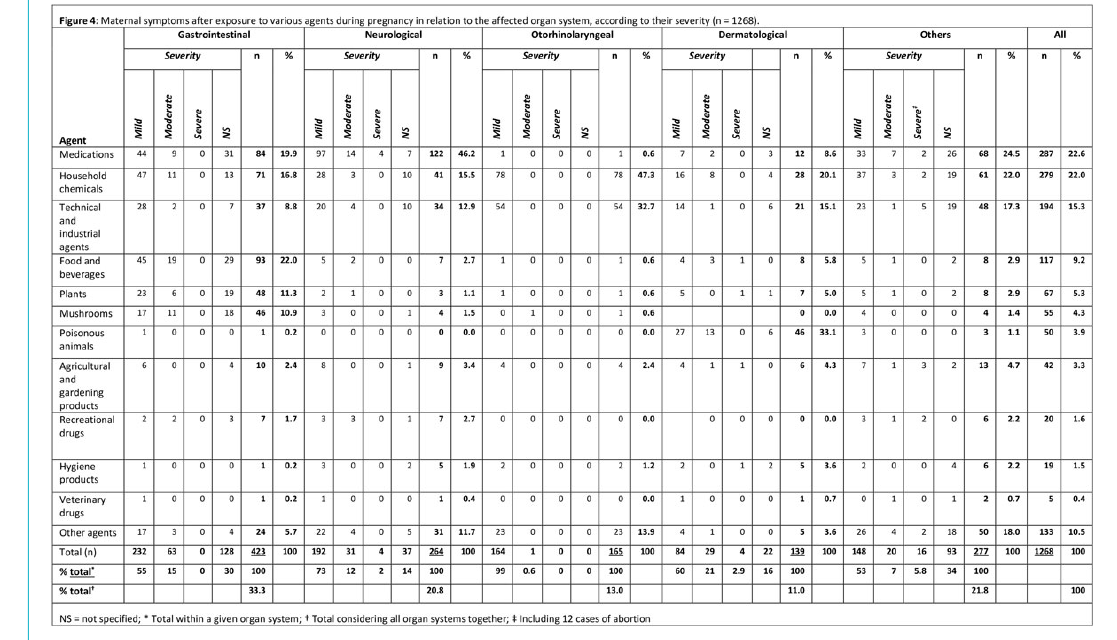
Figure 4: Maternal symptoms after exposure to various agents during pregnancy in relation to the affected organ system, according to their severity (n =